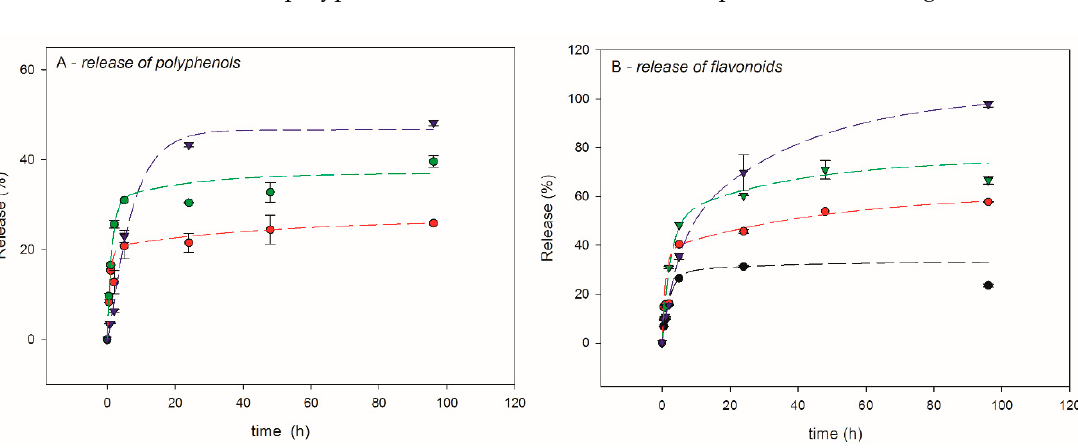
Figure 7. Tea release kinetics in water: ( A ) release of polyphenols and (B) release of flavonoids. Experimental results: black dots (ET5), red dots (ET10), green dots (ET15) and blue dots (ET20). The corresponding exponential fitting are shown by dashed lines.